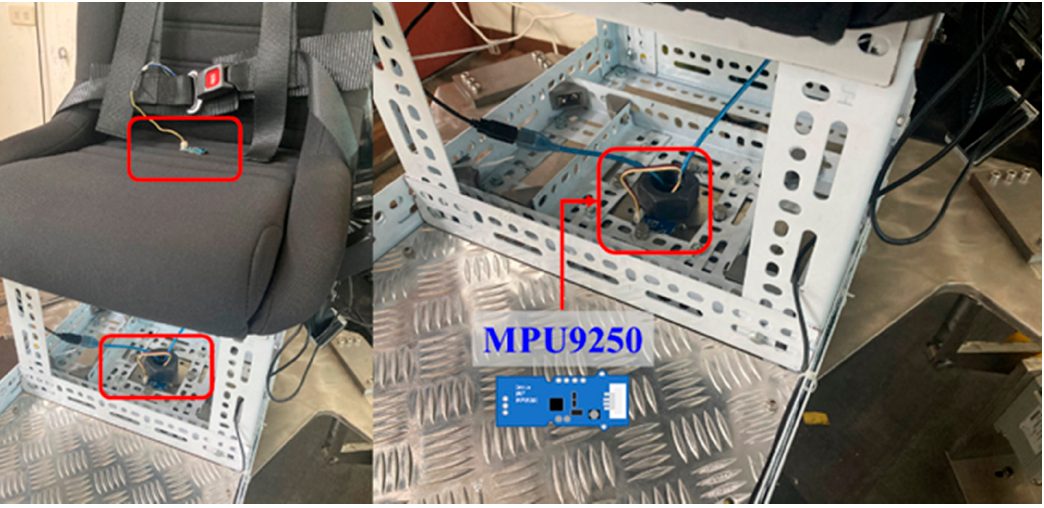
Figure 30. The installation location of motion sensor. The trajectory error of roll motion was 0.04~0.91 ◦ , the average error was 0.29 ◦ , and the measurement standard deviation was 0.17. The comparison of roll motion is shown in Figure 31a. In the pitch motion, the trajectory error was 0.18~0.72 ◦ , the average error was 0.4 ◦ , and the measurement standard deviation was 0.17. The comparison of pitch motion is shown in Figure 31b. To sum up, the platform’s motion angle return reliability was 97.43%.